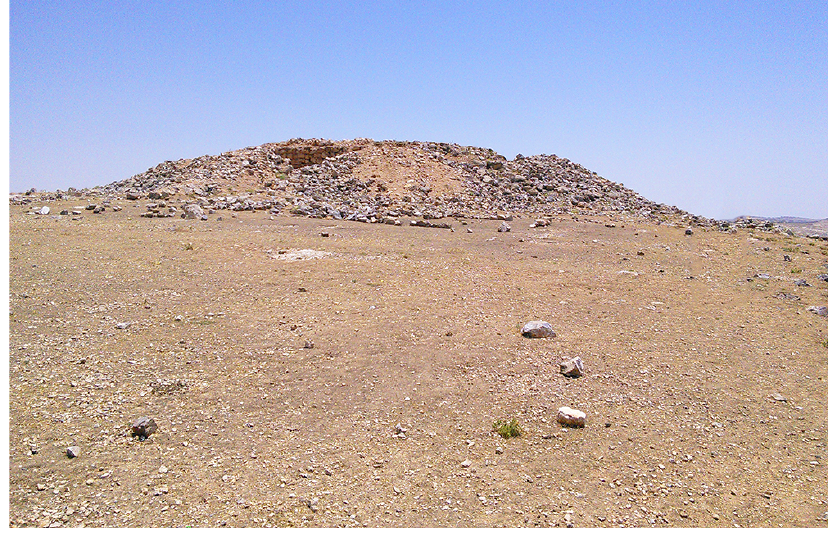
Figure 6: The ruined watchtower at Rujm al-Mukhayyat as seen from the north (photo by S.